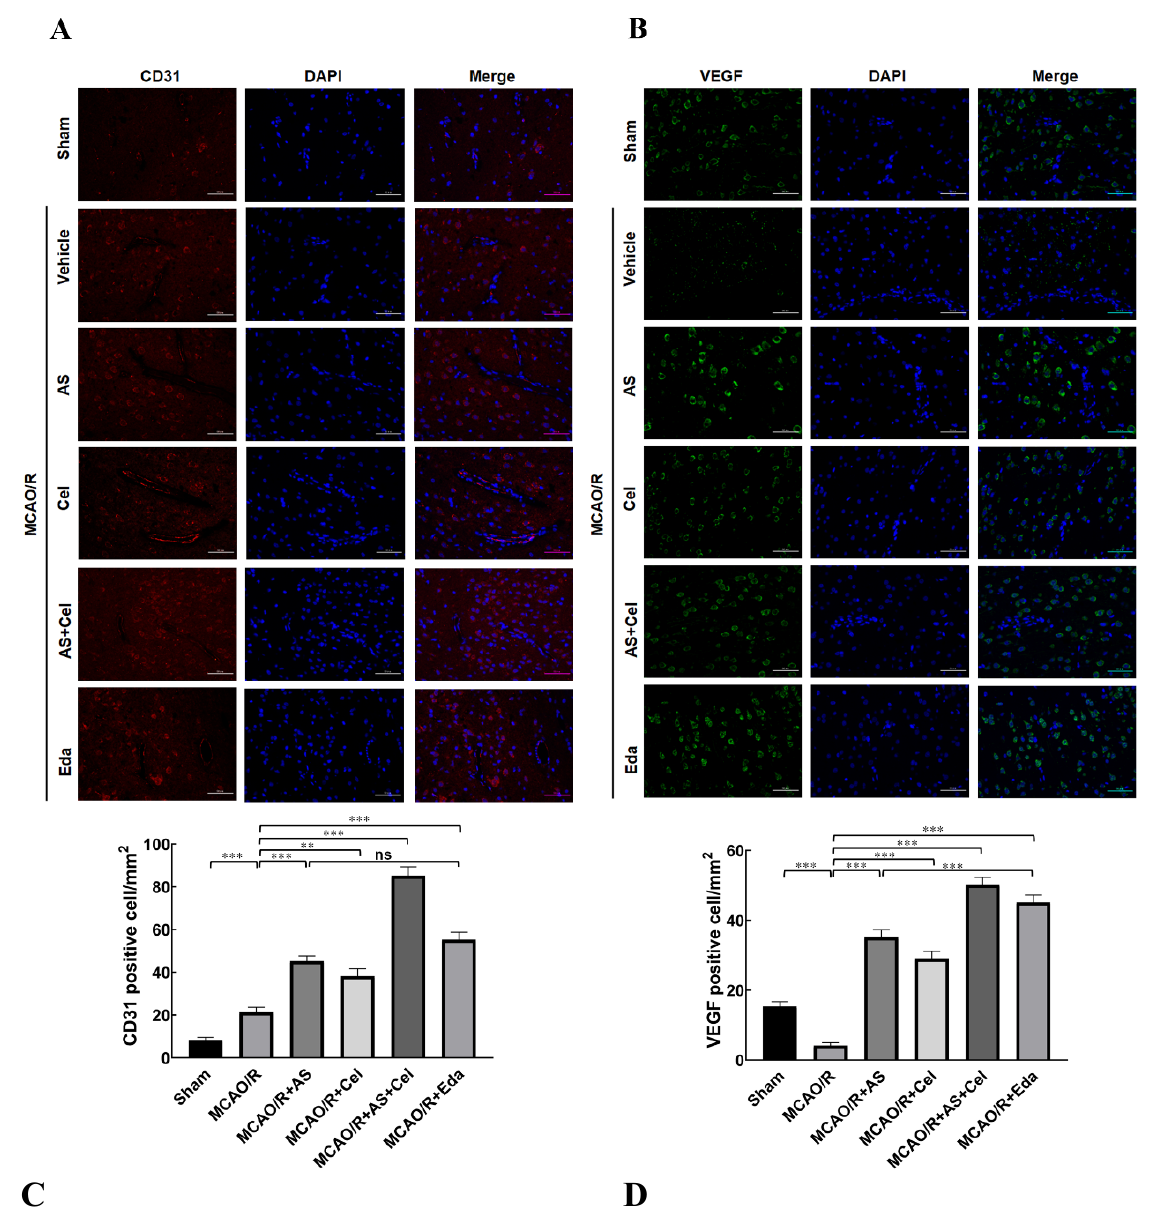
Figure 6. AS treatment promoted angiogenesis. ( A ) The immunofluorescent staining (magnification was 400 × ) of CD31 and ( B ) quantitative analysis. ( C ) The immunofluorescent staining (magnification was 400 × ) of VEGF and ( D ) quantitative analysis. Red fluorescence indicates CD31 signal, and green fluorescence indicates VEGF signal. (n = 3 rats for each group). Data are expressed as the mean ± SD, ** p < 0.01, *** p < 0.001; ns stands for no statistical